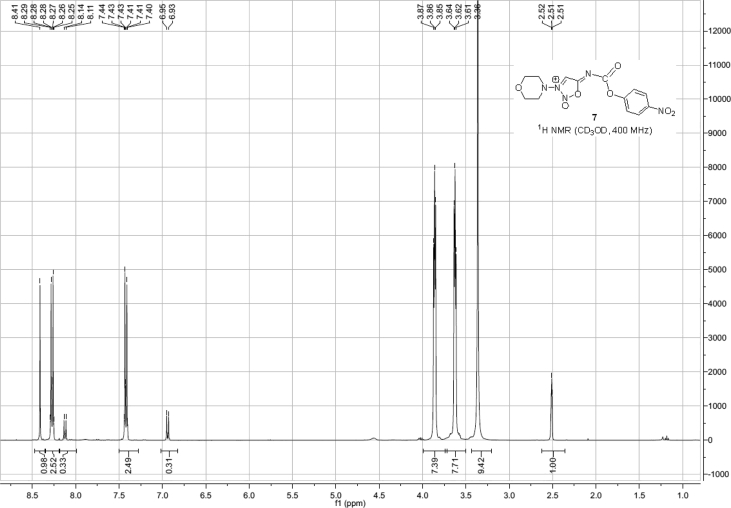
1H NMR spectra of compound 7.